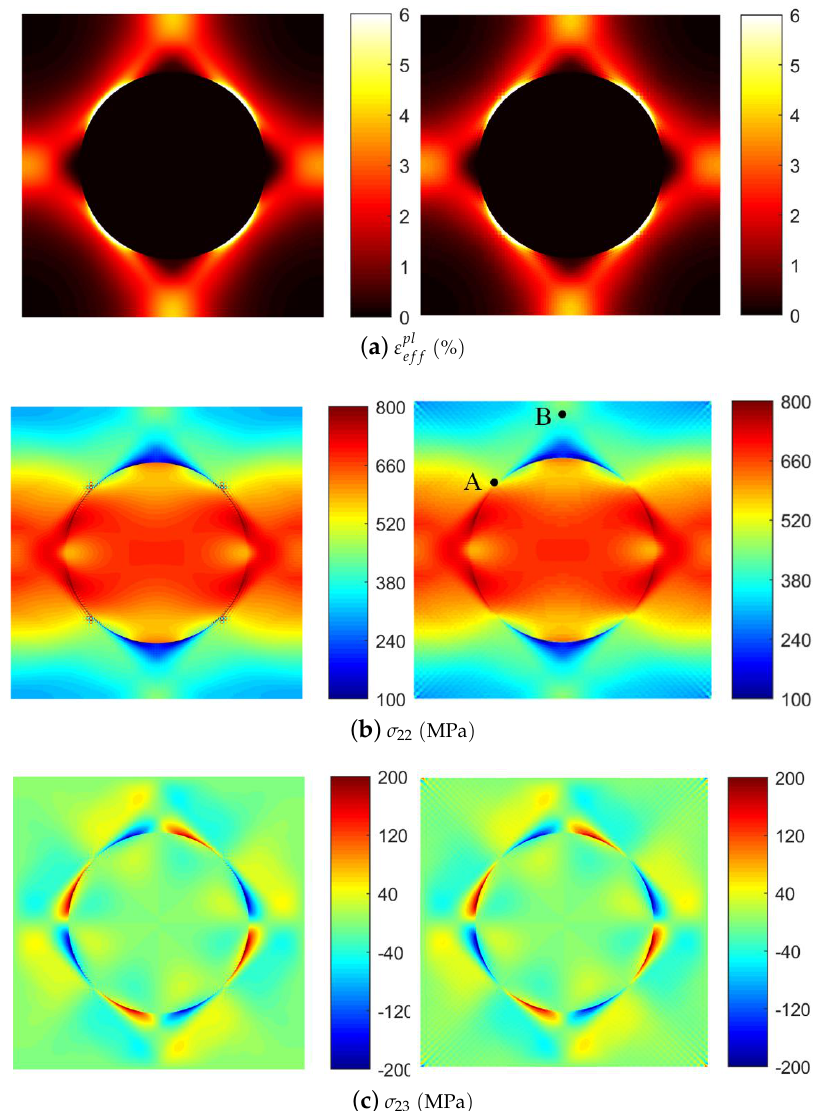
Figure 6. Local field distributions ( µ = 0.15) after ∆ T = − 550 ◦ C cooldown followed by the applied strain ¯ ε 22 = 1%: FEM (left); FVDAM